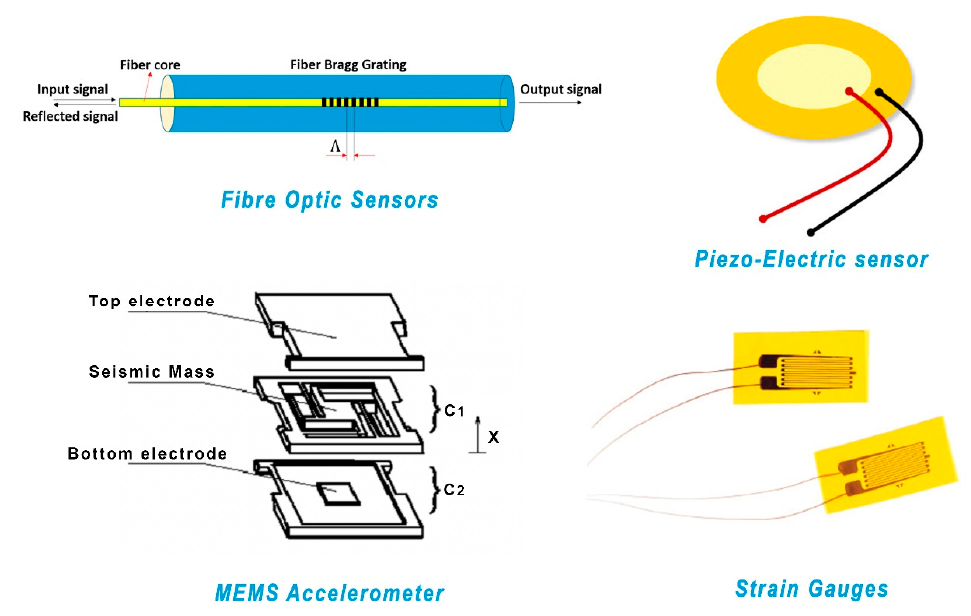
Figure 3. Various sensors used for SHM.